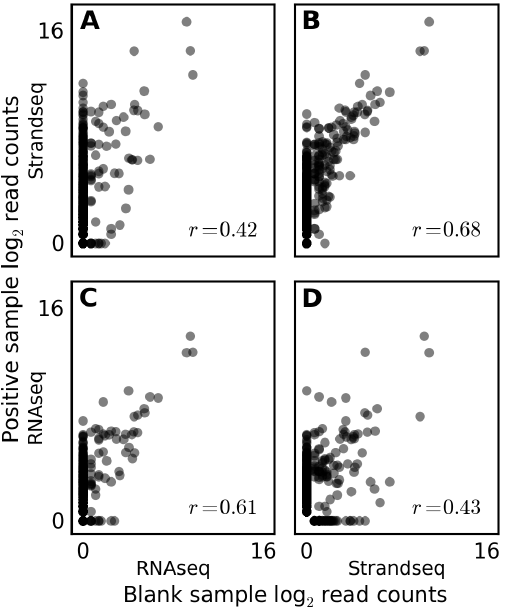
Figure 3. Experiment-specific correlation between distribu- tions of genera recovered from ‘blank’ and positive samples. The ‘‘RNAseq’’ [25] and ‘‘Strandseq’’ [24] experiments sequenced libraries prepared from blank samples into which no cells had been introduced. Reads from these blank samples and from all other samples were separately pooled, screened against the mouse reference genome, and queried against the BLAST NR database. Reads were screened using the same criteria as described for Figure 2, but adjusted to the genus taxonomic level. The number of reads matching each genus in each dataset was counted, incremented by one, and log transformed. Values for the pooled positive samples (StrandSeq and RNAseq in rows A-B and C-D, respectively) are plotted with their Pearson correlation against values for the pooled negative samples (Strandseq and RNAseq in columns A-C and B-D, respectively). Matched positive and negative samples in (B) and (C) exhibit more correlated read counts than do mismatched positive and negative samples in (A) and